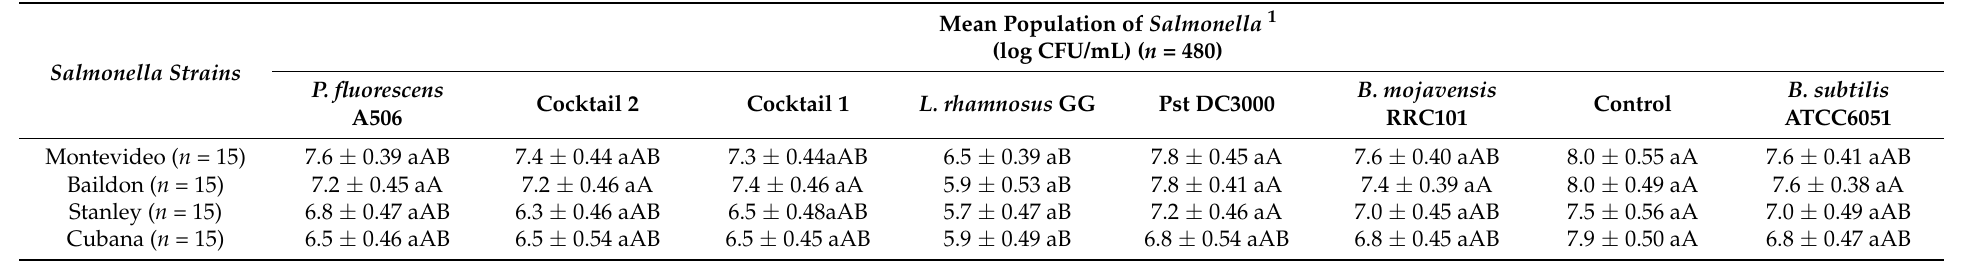
Table 3. Mean populations of individual Salmonella strains in co-cultures with different competitive bacterial strains and the plant pathogen at 25 ◦ C.